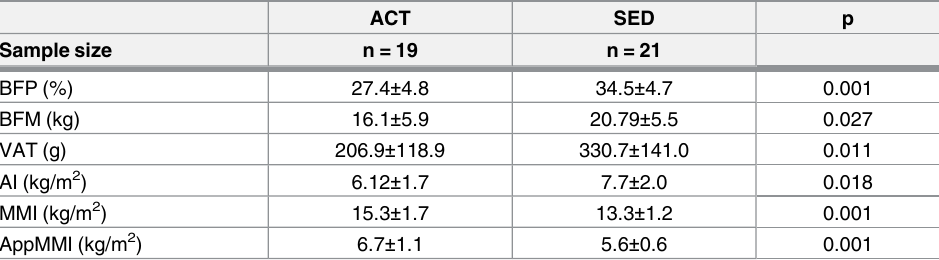
BFP: body fat percentage; BFM: body fat mass; VAT: estimated visceral fat; AI: adiposity index;